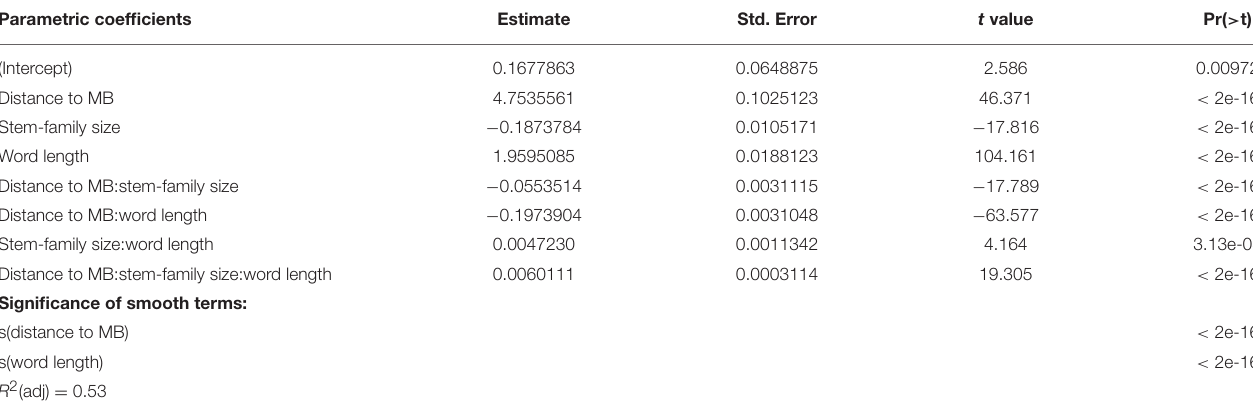
TABLE 2 | GAM fitted to word learning epochs using stem-family size as the only paradigmatic predictor: learning epoch ∼ stem-family size * distance to MB * word length + s( distance to MB ) + s( word length ). Parametric